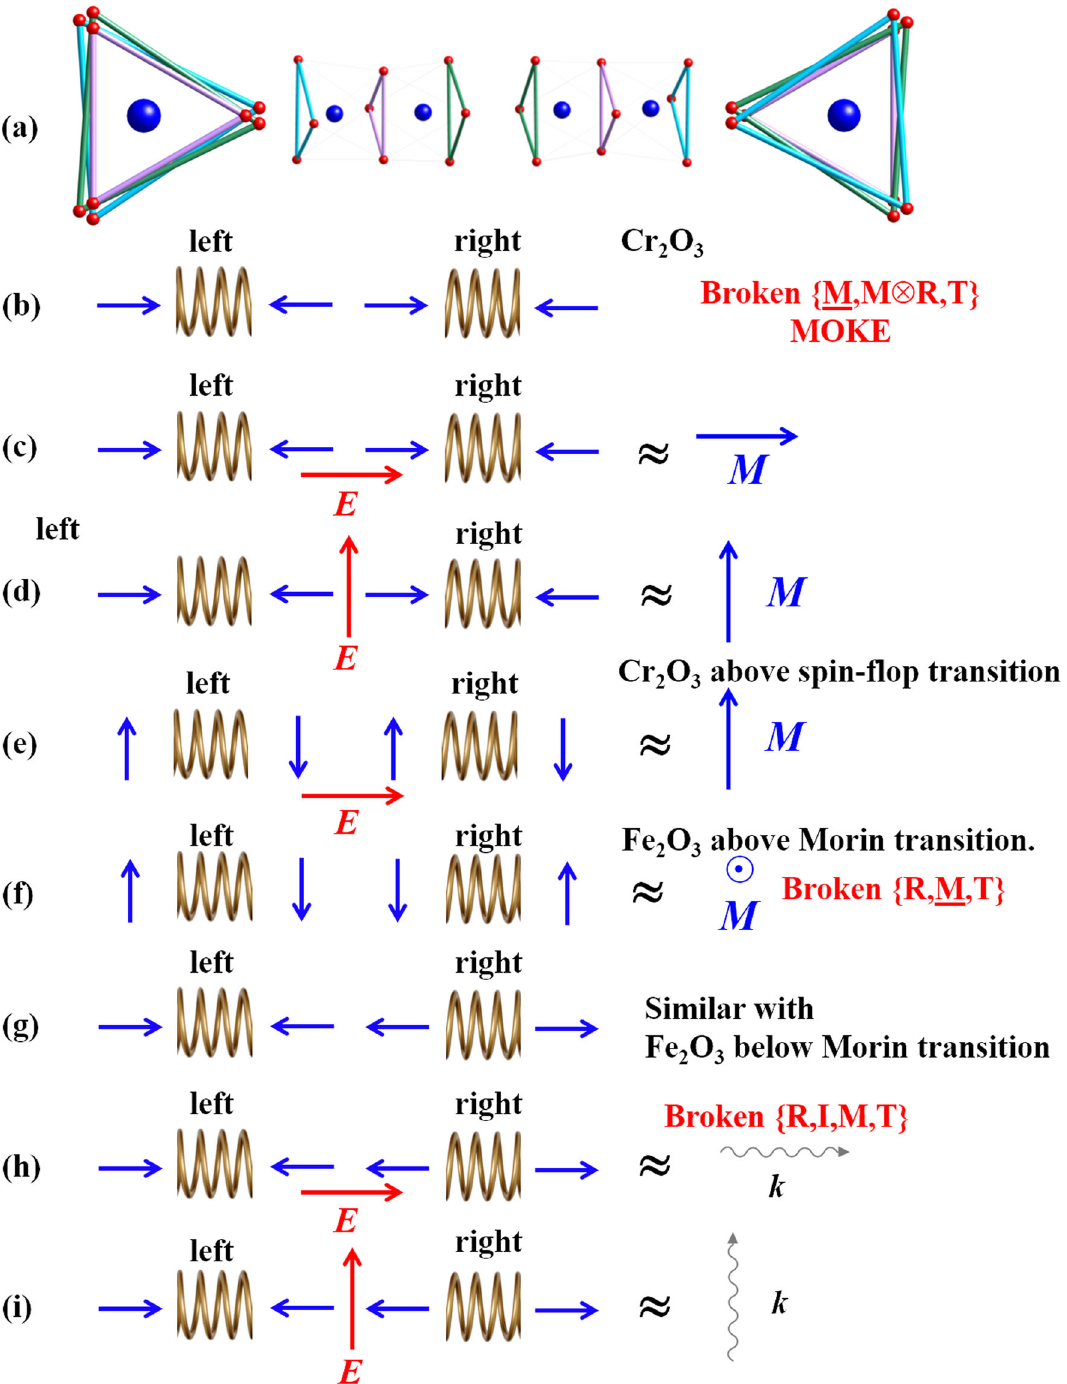
2 O 3 , and left-chiral and right-chiral arrangements of three oxygen tringles are shown in the left-hand-side and right-hand-side projections along the c axis, respectively. b The magnetic state of Cr 2 O 3 with broken { M , M ⊗ R , T }, so can exhibit MOKE. c , d The magnetic